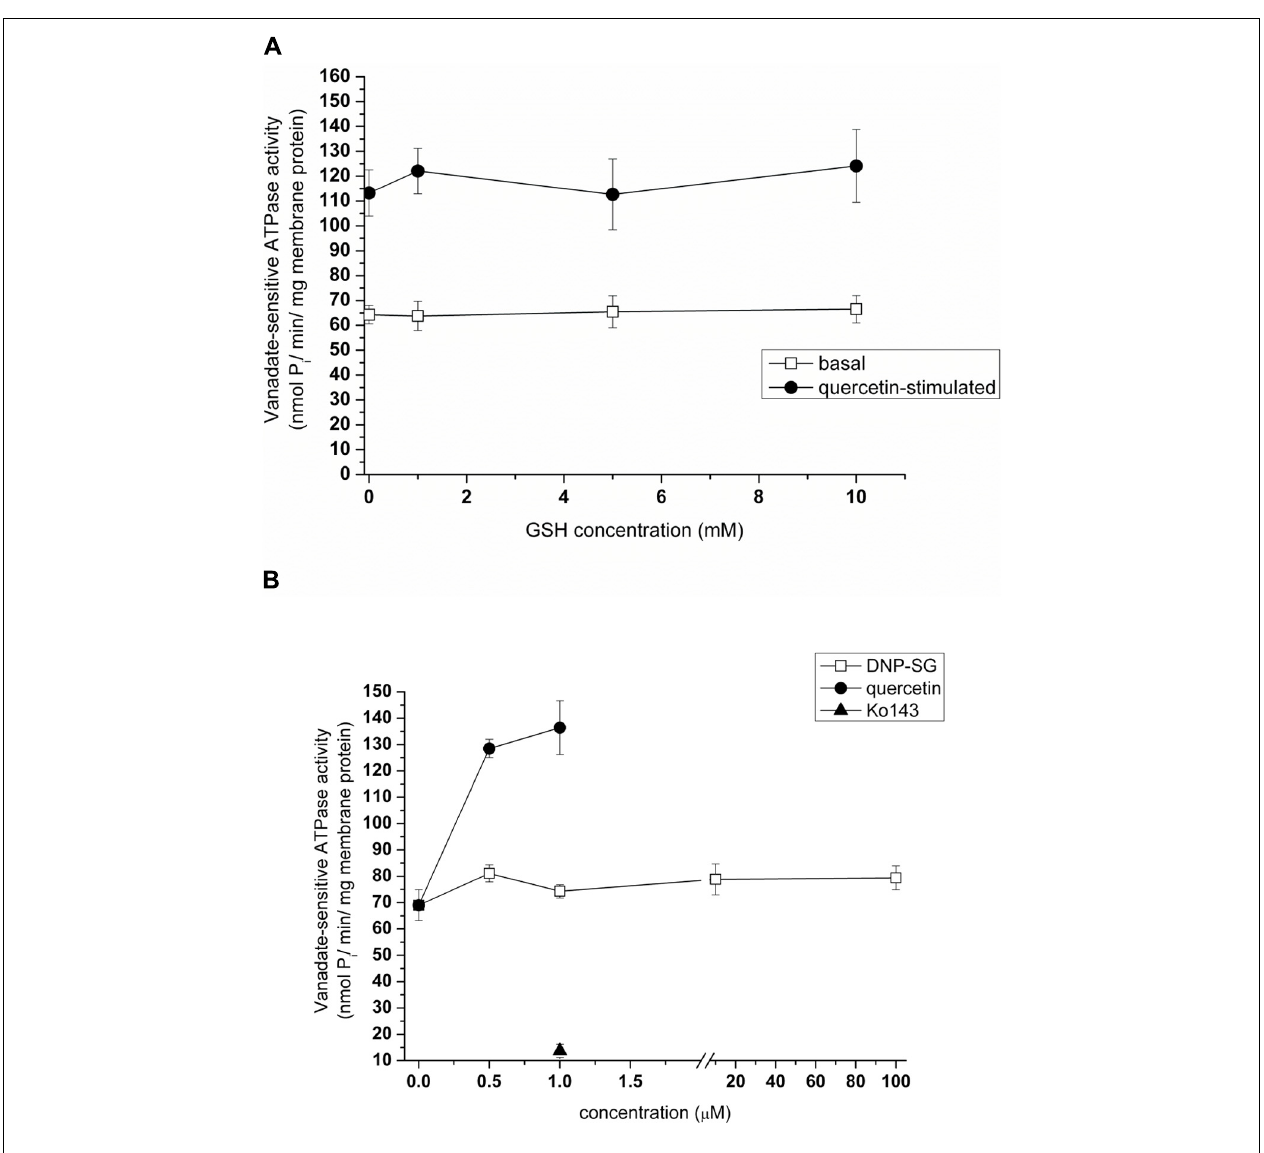
transported substrate (1 μ M quercetin, “quercetin-stimulated”) without producing any significant effect. It was also assayed with increasing concentrations of DNP-SG or quercetin or with 1 μ M Ko143 (B) . Data points represent the average ± SD values of two independent